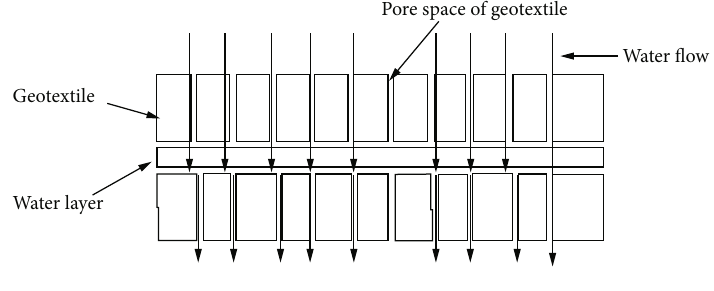
Figure 13: Water fl ow through the geotextile.